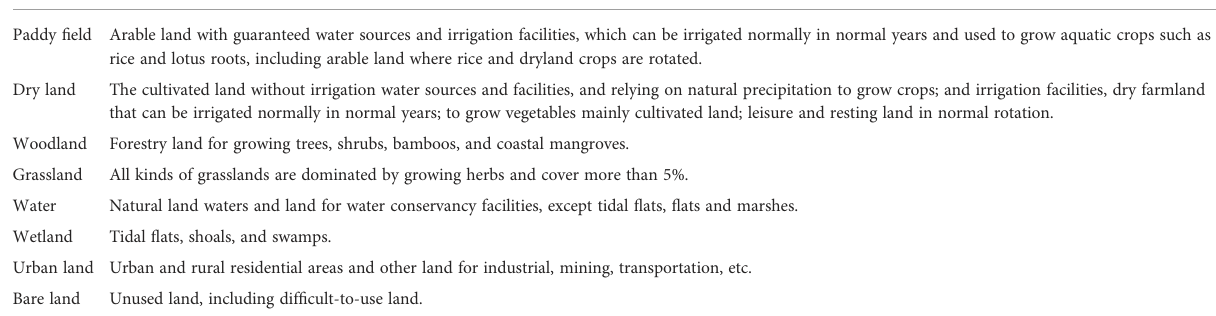
TABLE 2 Land cover classi fi cation system. Land